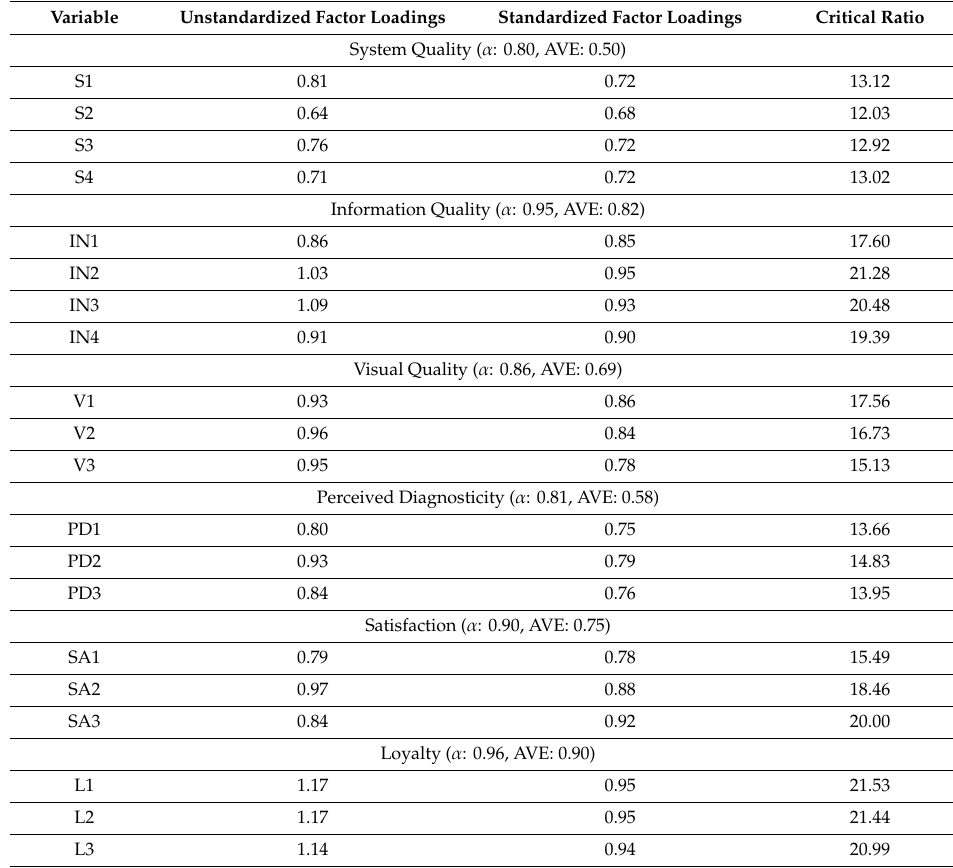
Table 2. Results of the confirmatory factor